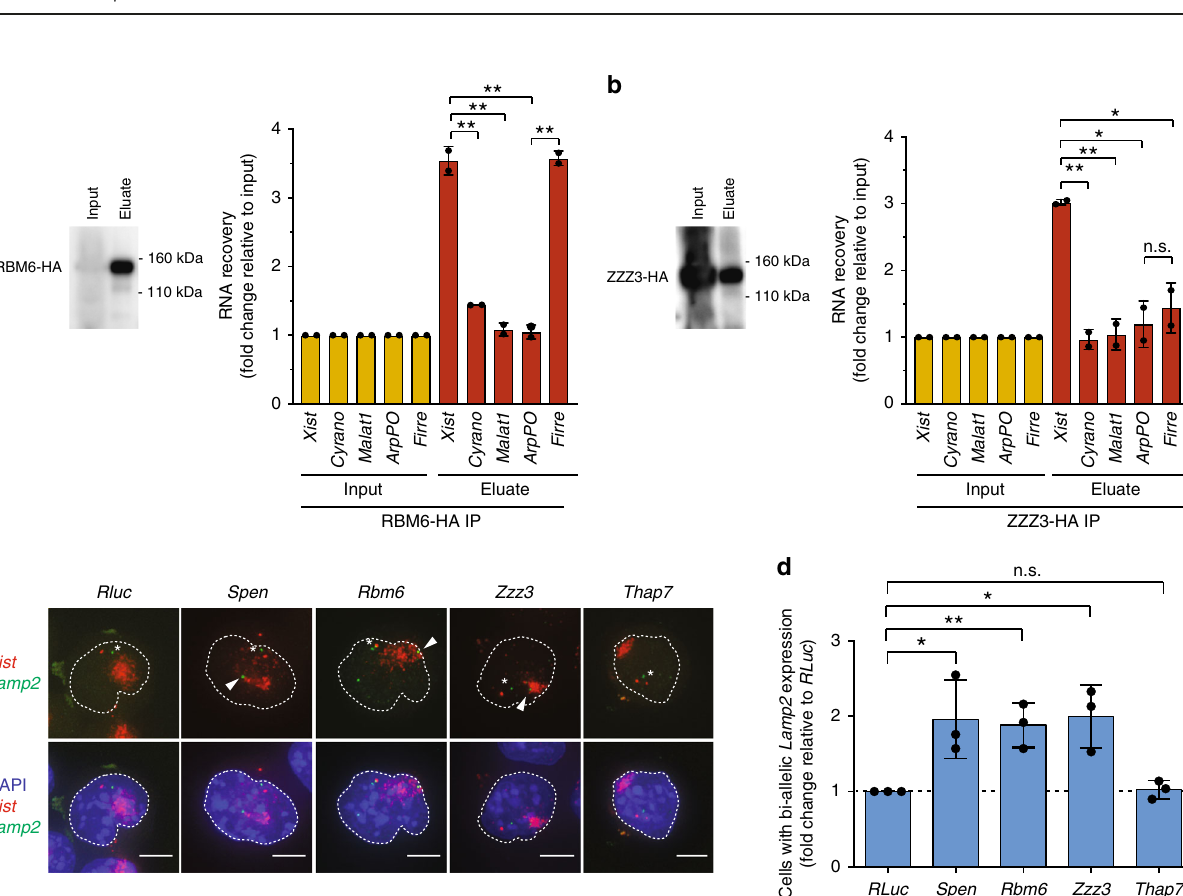
Fig. 4 Proteins identi fi ed to interact with distinct regions of the lncRNA Xist . a Schematic representation of the mouse Xist transcript and its A- to F- conserved repeat regions. Exons are indicated as boxes, introns as lines. A zoom-in image of the 5 ′ region of Xist shows the positions of Xist fragments along the Xist transcript. The 0.9-kb, 2-kb, and 1.7-kb fragments for Xist(A) , Xist(F) , and Xist(C) , respectively, used in the incPRINT experiments are delimited by horizontal colored bars. b Normalized Xist(A)- protein interaction intensities averaged from two biological replicates, sorted in increasing order. The horizontal dotted line represents the interaction intensity cutoff used for the classi fi cation of Xist(A) interactors. Red dots are Xist(A)- interacting proteins; gray dots are proteins that do not bind to Xist(A) . Selected proteins known to bind to Xist are indicated. See the ‘ Methods ’ section for data normalization. RLU are relative light units. c As in ( b ), for Xist(F) . d As in ( b ), for Xist(C) . e Heatmap showing interaction intensities between Xist(A) , Xist (F) , and Xist(C) . Previously detected Xist -interacting proteins are indicated on the right. RLU are relative light units. f As in Fig. 3b, for Xist(A) , Xist(F) , and Xist(C) interaction partners. SPOC refers to Pfam domain PF07744.